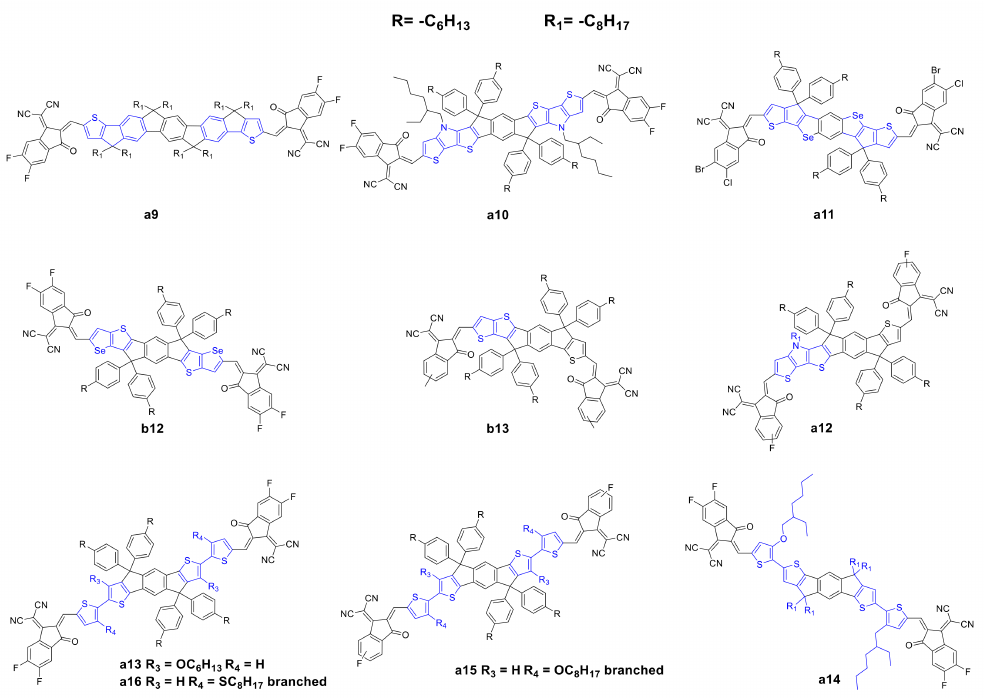
Figure 3. Structure of the acceptors of the IDIC / ITIC families, where the central core of a0 or b0 has been modified.